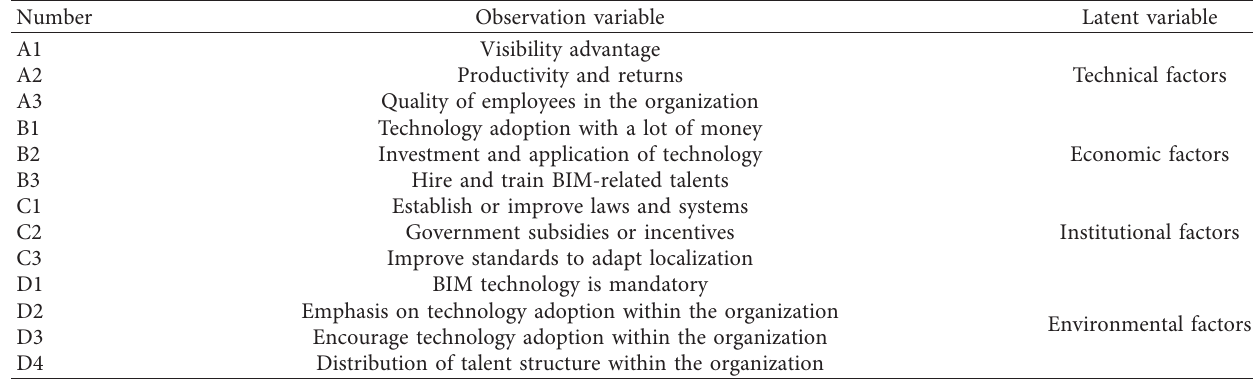
Table 1: Measurement